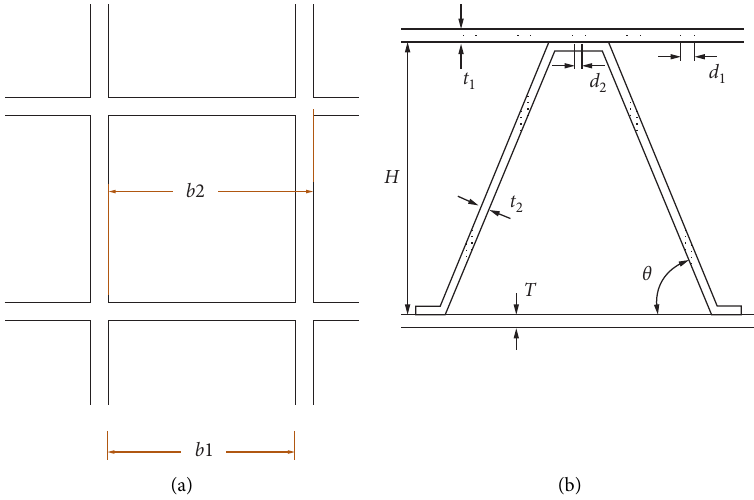
Figure 2: (a) Top view of the honeycomb core. (b) Front view of the sandwich panel.